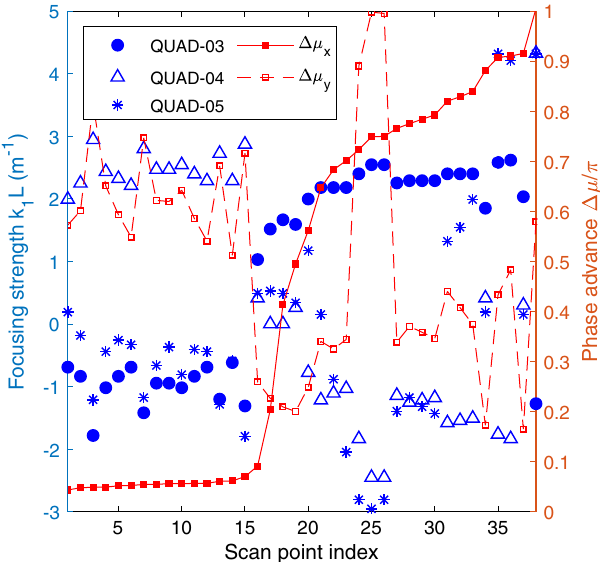
FIG. 2. Strengths of quadrupoles QUAD-03, QUAD-04 and QUAD-05 used during quadrupole scans. The quadrupole strengths are chosen to provide a wide range of phase advances from SCR-02 (the reconstruction point) to SCR-03 (the obser- vation point): the horizontal and vertical phase advances are shown on the plot as solid and broken lines